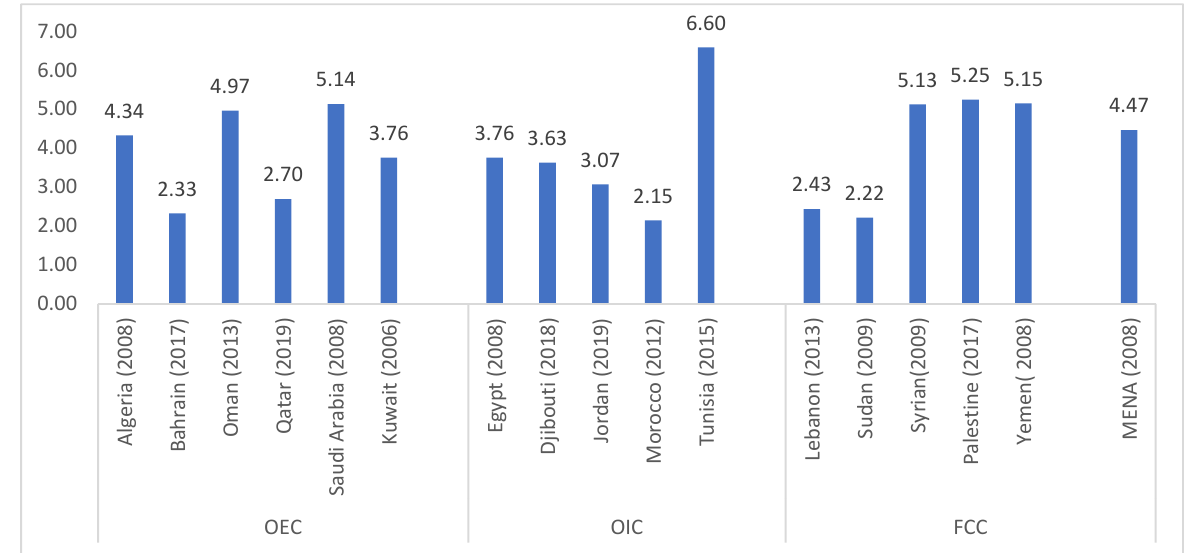
Figure 3. Government expenditure on education, total (% of GDP). Source: World Development Indicators. Available online: https://datacatalog.worldbank.org/ (accessed on 15 July 2021). Note: FCC: Fragile Crisis affected Countries, OEC: Oil Exporting Countries, and OIC: Oil Importing Countries.